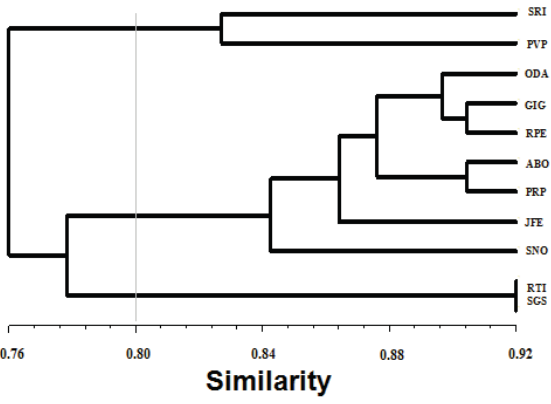
Figure 1 - Analysis of grouping by the UPgMA method of accessions of Lippia rotundifolia Cham. from eleven naturally occurring populations in Minas gerais, Brazil. SRI: Santana do Riacho in lapinha; PVP: Veredas do Peruaçu State Park; ODA: APA de Olhos D´água; gIg: gigante Community in Botumirim; RPe: Rio do